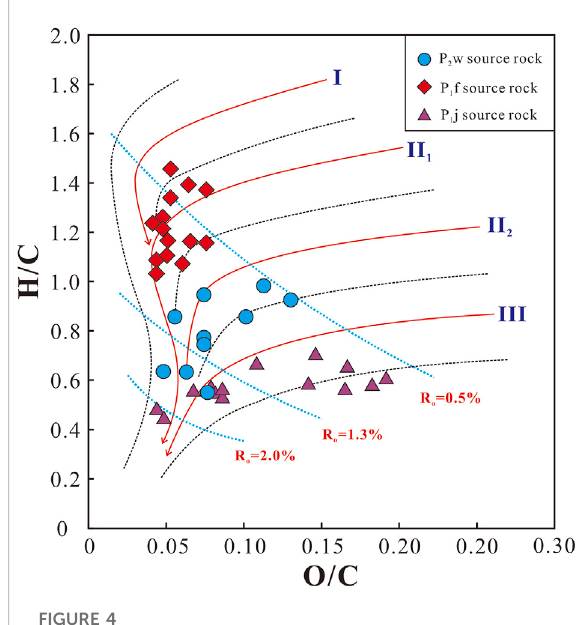
FIGURE 4 Plot of O/C atomic ratio versus H/C atomic ratio from P 2 w, P 1 f, and P 1 j source rock samples. The base map modi fi ed from Van Krevelen